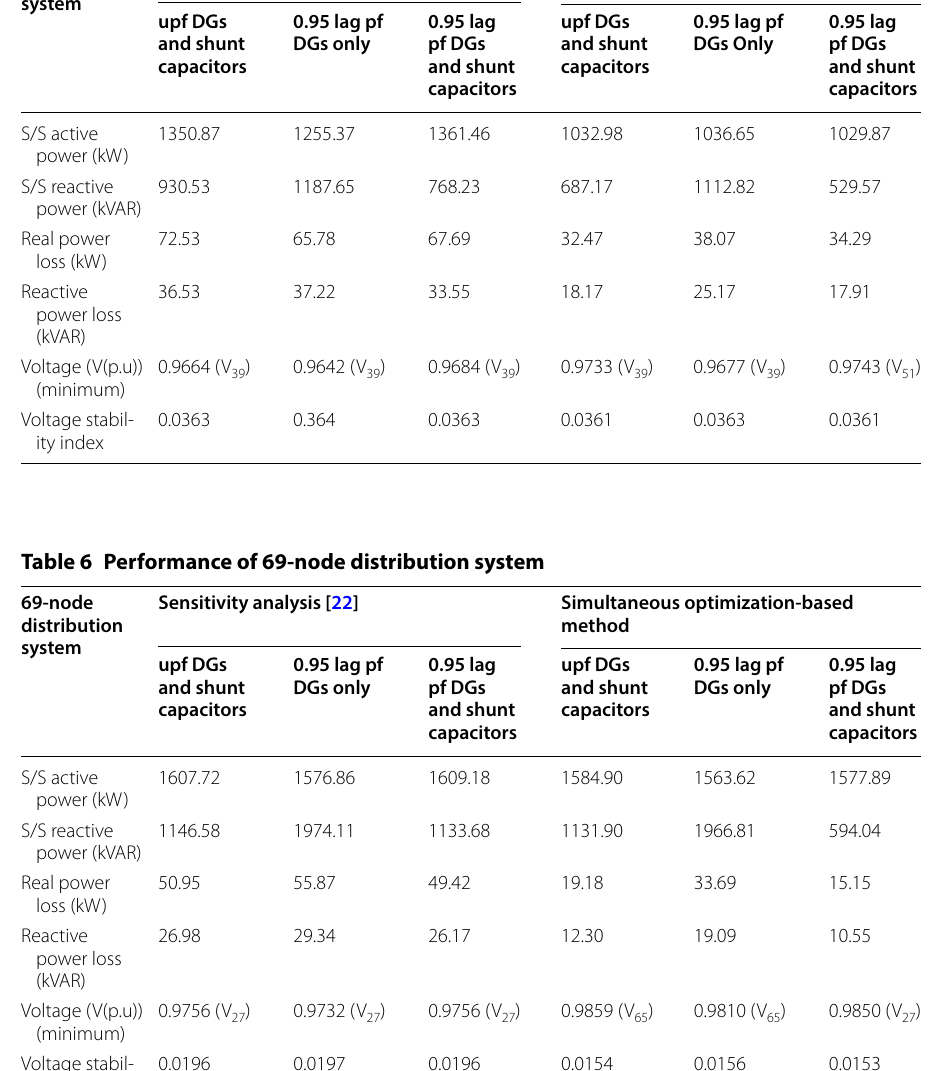
Table 5 Performance of 51-node distribution system 51-node distribution